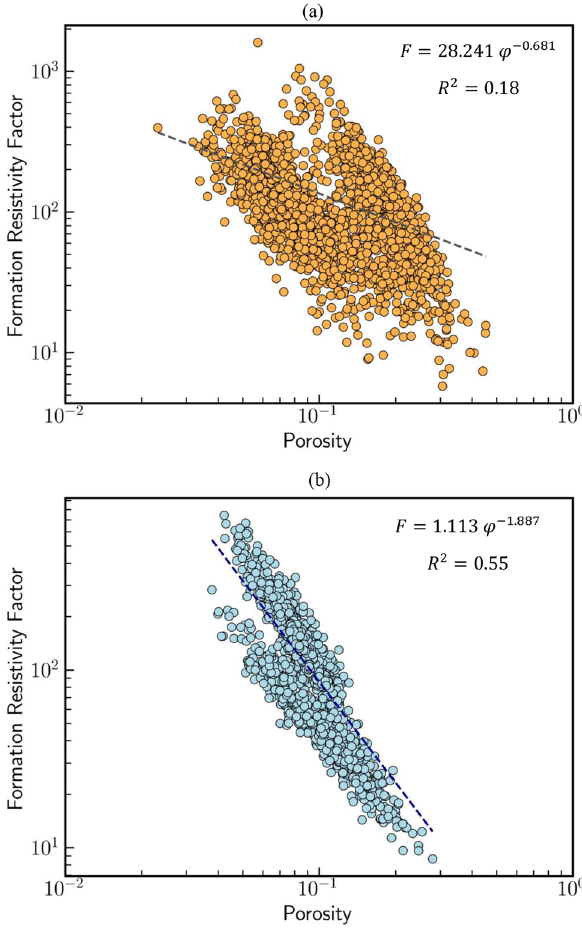
Fig. 3 Applying traditional Archie’s law on training datasets referring to a carbonate and b sandstone samples,